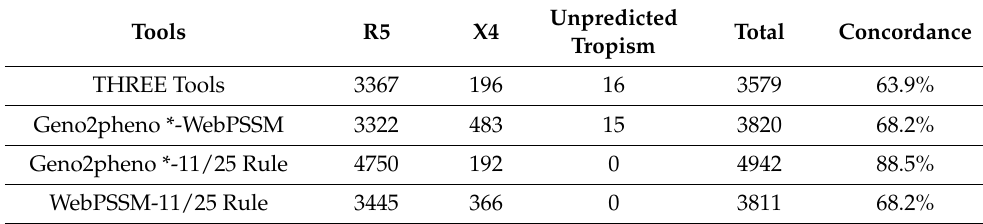
Table 2. Concordance of the three